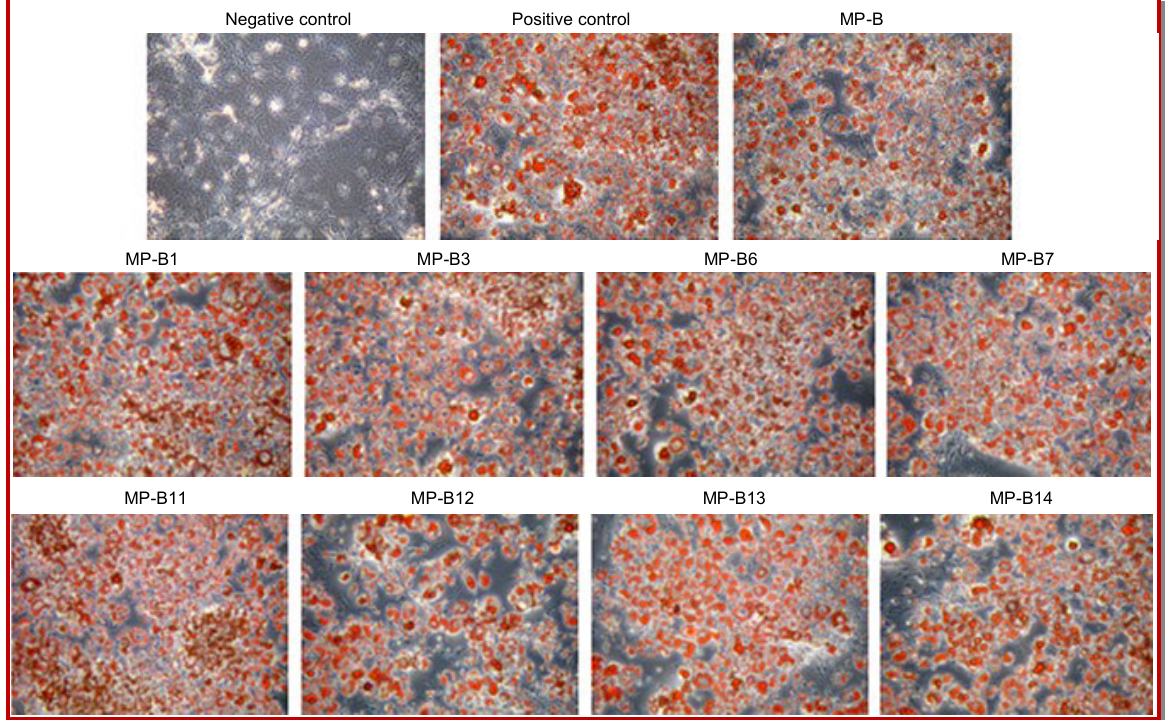
Figure 1: Effect of MP-B and its analogue on intracellular lipid accumulation in 3T3-L1 cells. The cells were cultured with MP-B and its analogue (10 μ M) and stained by Oil Red O